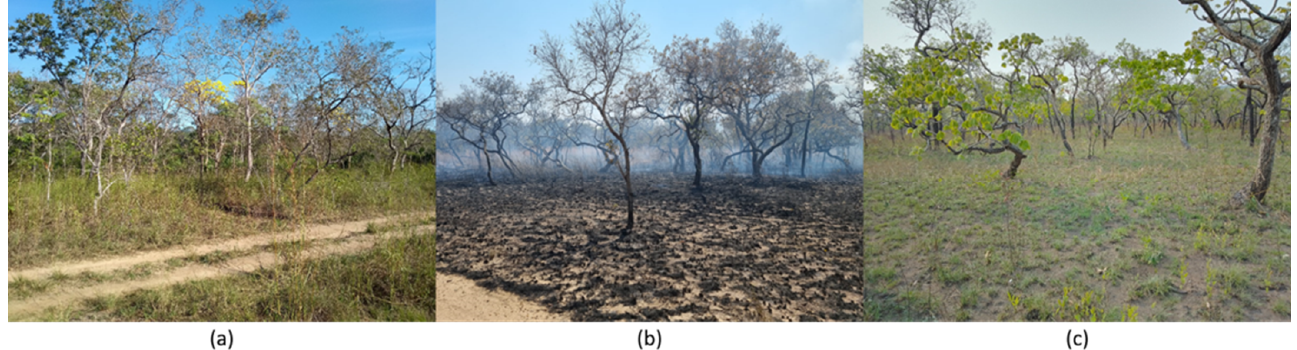
Figure 2. The aspect of the study sites in the Kadiwéu Indigenous Reserve changes throughout the year, as seen at the beginning of the dry season in June 2021 ( a ), at the end of the dry season in August 2021 ( b ), and at the beginning of the wet season in October 2021 ( c ).